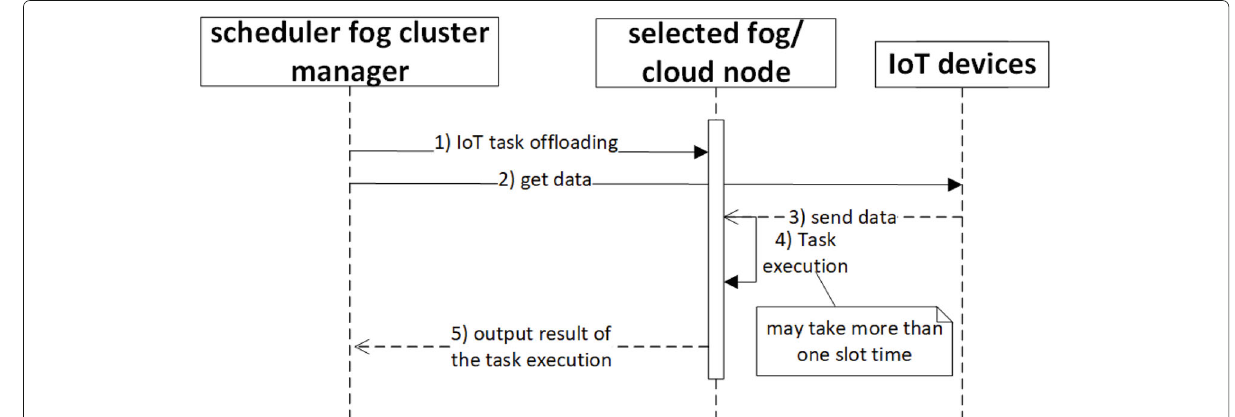
Fig. 3 The process of task execution